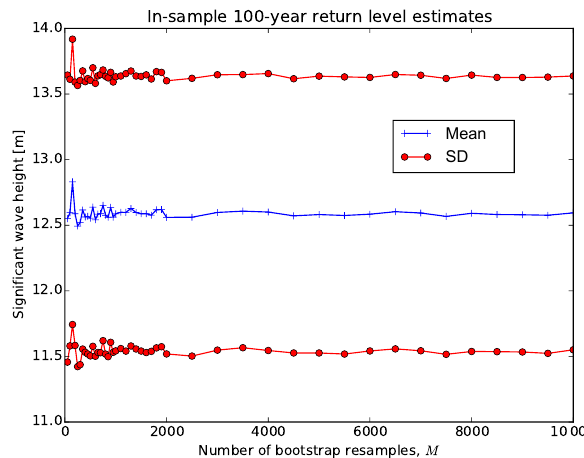
Figure 6. Mean and standard deviation on 100-year in-sample re- turn estimates with a threshold K 0 = 1000 as a function of number of bootstrap resamples, M . For M > 1000 the CIs are quite stable.